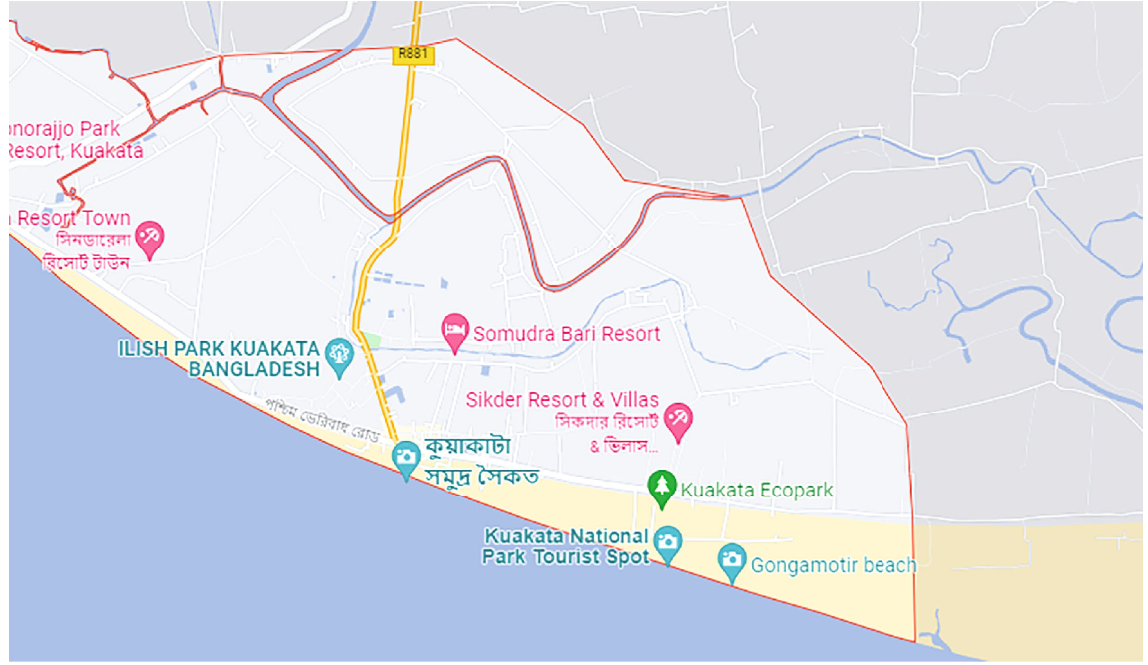
Figure 1: Geographical position of the southern area of Bay of Bengal (Kuakata), Bangladesh (21 ° 49 ′ 16 ″ N 90 ° 07 ′ 11 ″ E).